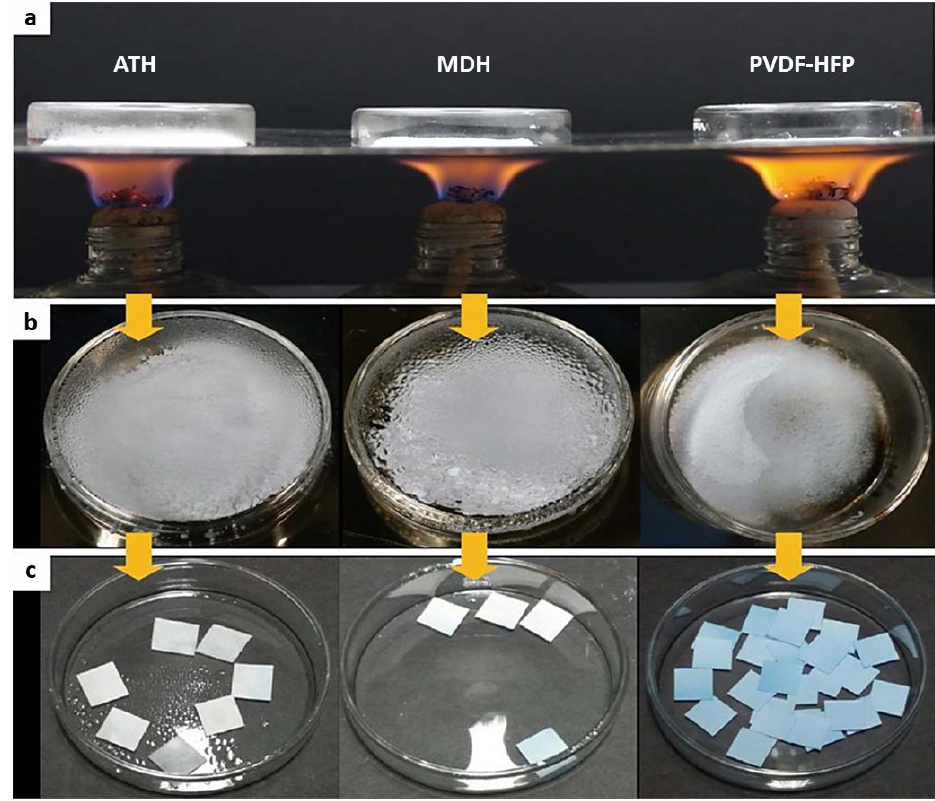
Figure 31. Images showing the setup for the heating experiment: ( a ) Side view and ( b ) top view. ( c ) Digital camera images of cobalt chloride (CoCl 2 ) paper method for ATH and MDH. The color of the cobalt chloride paper turned from blue to white-pink, implying that the liquid droplets formed during heating were water. Reprinted with permission from Ref. [86]. Copyright 2015, Elsevier.